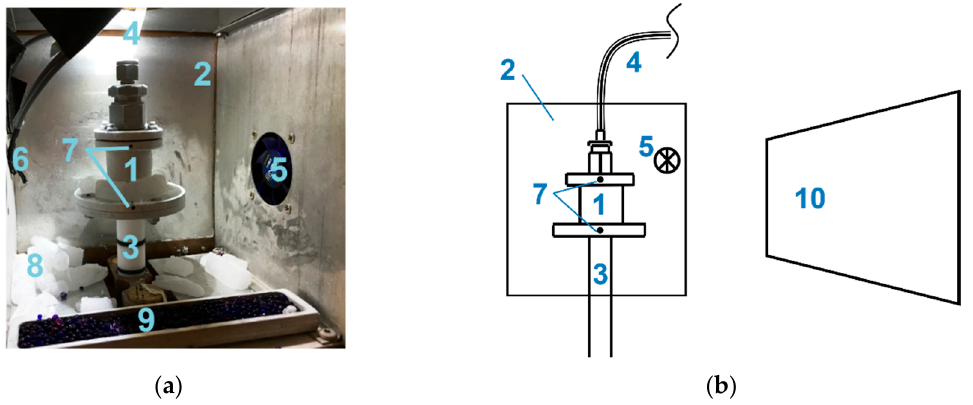
Figure 2. ( a ) Picture of the drying chamber mounted on the sample holder inside the climate chamber [27]. ( b ) Schematic sketch of the set-up. The front door is not shown; 1: drying chamber with sample, 2: climate chamber, 3: rotating sample holder, 4: exhaust pipe to Pirani sensor and vacuum pump, 5: